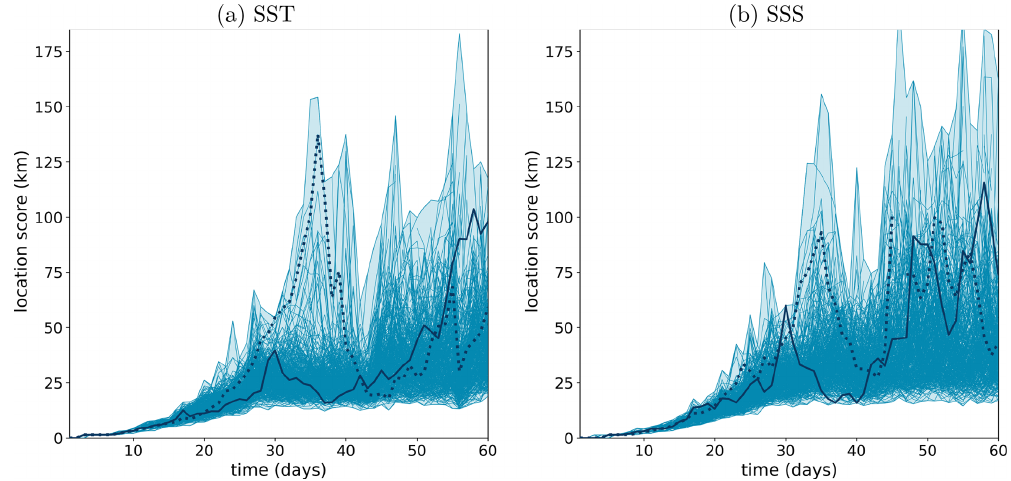
Figure 14. Time evolution of the location score ( y axis, in km) for (a) SST and (b) SSS in experiment ENS-CI. The score is computed for each of the 20 × 19 permutated pairs (blue lines) considering one ensemble member as the reference truth and each of the 19 remaining ensemble members as a forecast. The blue shading represents the minimum-to-maximum envelop of all the 20 × 19 scores computed for the experiment. Two example lines are plotted thicker (solid and dotted lines) in each panel to illustrate how individual scores can evolve with